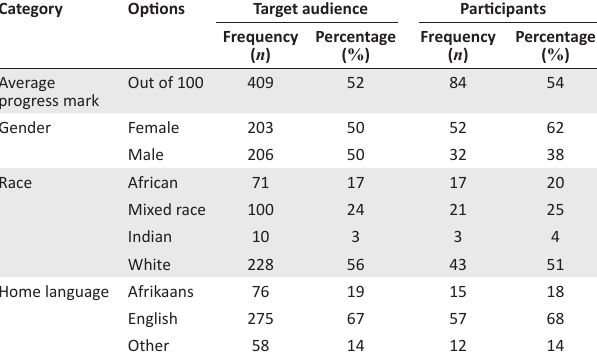
TABLE 1: Demographics and average progress mark of target audience and participants.